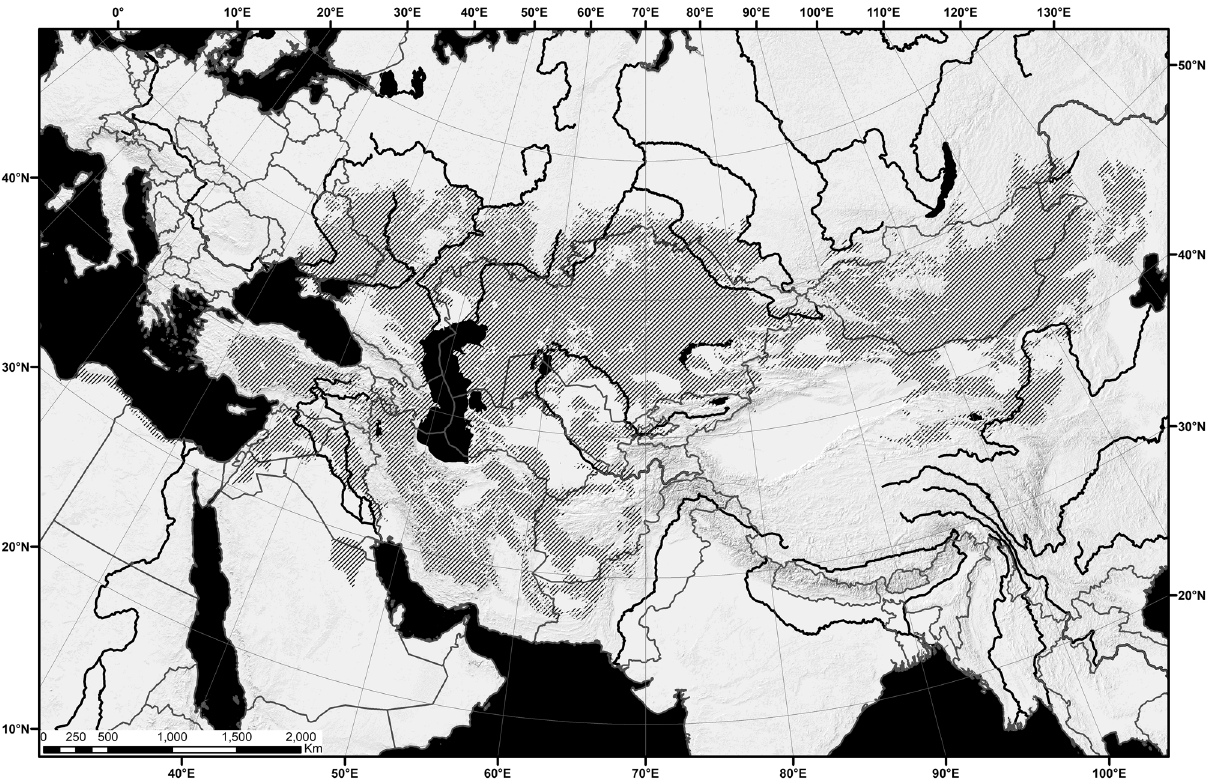
Figure 1. Geographic range of the Allactaginae subfamily. Hatched area corresponds to the combination of distribution ranges of all recent species (Fig. S1A–E). Distribution ranges of recent species were obtained as raster maps from modeling using MAXENT 3.4.1 software and then generated as polygon maps using ArcGIS Desktop 10.8.1 software. MAXENT: available at https:// biodi versi tyinf ormat ics. amnh. org/ open_ source/ maxen t/. ArcGIS Desktop: Copyright © 1995–2020